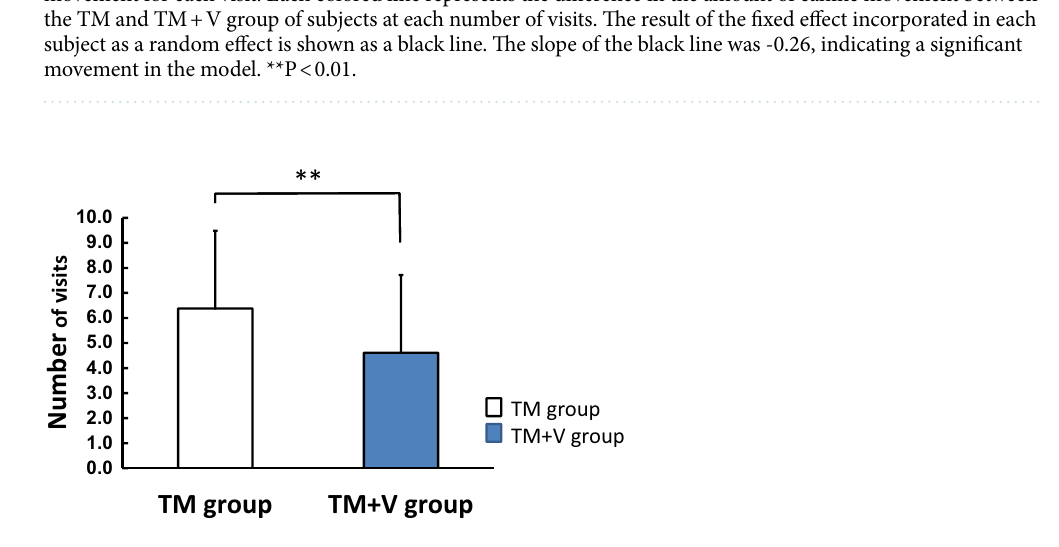
Figure 4. Estimated number of visits. TM + V group was estimated to have a lower number of visits than the TM group. **P <